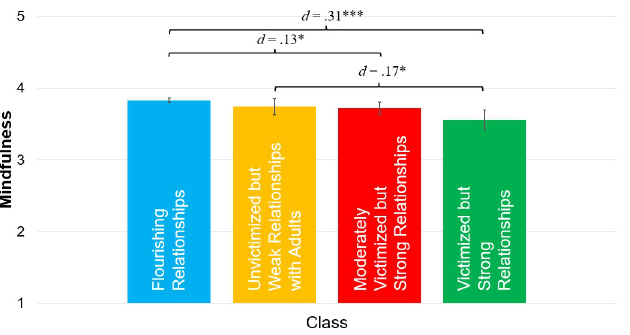
Fig 4. Mean differences in 7 th grade mindfulness across 4 th grade latent classes, adjusting for 4 th grade self- regulation and gender ( N = 4,100). Error bars are 95% confidence intervals; d = Cohen’s d . � p < .01. ��� p < .001.